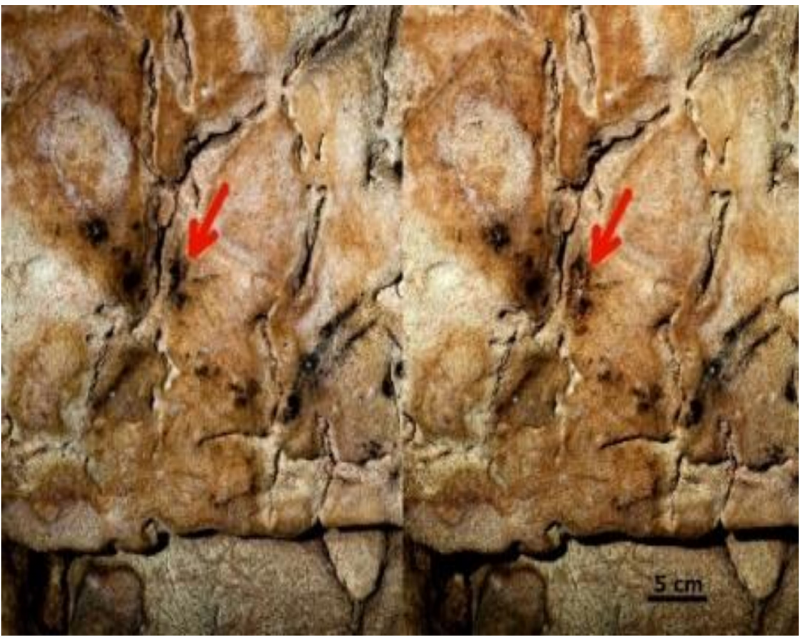
Figure 5. Sampling of “Brain” charcoal graffiti prior to sampling ( left ) and after sampling ( right